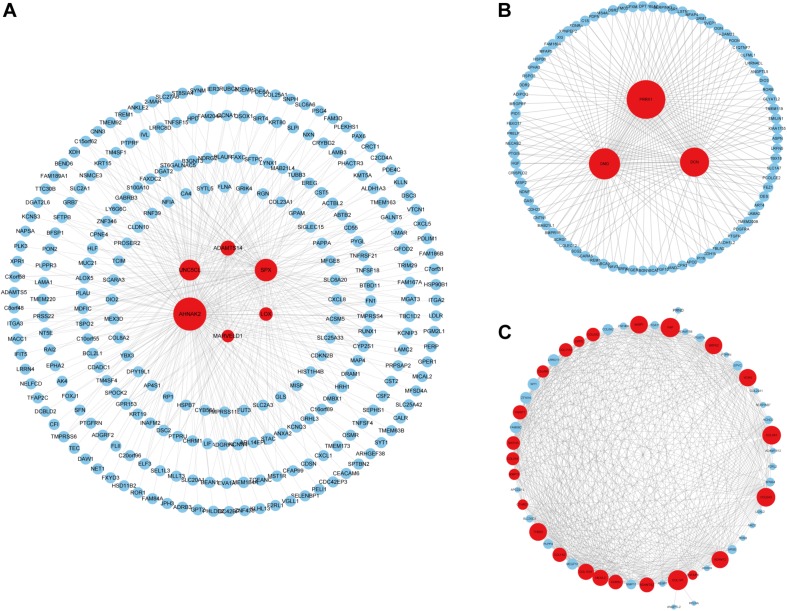
Construction of hub gene-centric interaction networks. (A) An interaction network centered on six hub genes in the brown module. (B) An interaction network centered on three hub genes in the greenyellow module. (C) An interaction network centered on 24 hub genes in the lightyellow module. Hub genes are shown in red and the point size indicates the node degree.